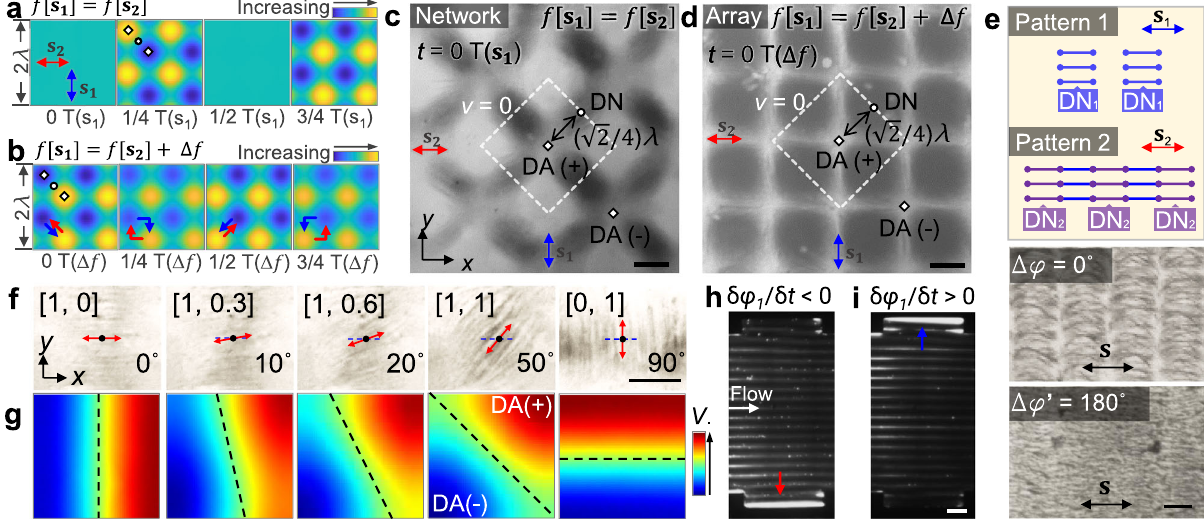
Fig. 5 Various nanomanipulation functions (e.g., pattern transformation, orientation control, and enrichment) via AENT. a – d Pattern transformation of carbon nanotubes with 2D waves. Analytical, time-lapsed electric potential distribution for a scenario f ( s 1 ) = f ( s 2 ) at time 0, ¼, ½, and ¾ T( s 1 ), and b scenario f ( s 1 ) ≠ f ( s 2 ) around time 0, ¼, ½, and ¾ T( Δ f ). The diamond and the circular symbols indicate the displacement antinodes (DA) and displacement nodes (DN) in a transient electric fi eld, respectively. The red and blue arrows in indicate the transition directions of DA( + ) and DA( − ), respectively. The carbon nanotube pattern transforms to form ( c ) networks or ( d ) a square-shaped array as a result of the two aforementioned excitation con fi gurations. The white dashed lines indicate the contour of zero-potential ( v = 0) for the transient electric fi eld ( t = 0 T). Label “ T ” represent the time period of the frequency components of f [ s 1 ] or Δ f . e Schematic and experimental images of creating interconnected graphene sheets with uniform orientation by overlaying different 1D patterns with phase variances. f Experimental demonstration and g simulations of the orientation control of nanomaterials (i.e., carbon nanotubes) by tuning the 2D amplitude distribution. h , i Enrichment of 100 nm polystyrene beads in continuous fl ow with boundary con fi nement using phase-sweeping acoustoelectronic waves. The blue and red arrows indicate the phase-shifting directions of standing waves. The pattern of nanoparticles continuously shifts ( h ) downward ( δφ 1 / δ t < 0) or ( i ) upward ( δφ 1 / δ t > 0) in fl ow and the nanoparticles fi nally become trapped in the groove on the corresponding side wall. The labels “ s ” with bi-directional arrows indicates the direction of standing waves. Scale bars: c – f : 30 μ m; h , i : 120 μ m.